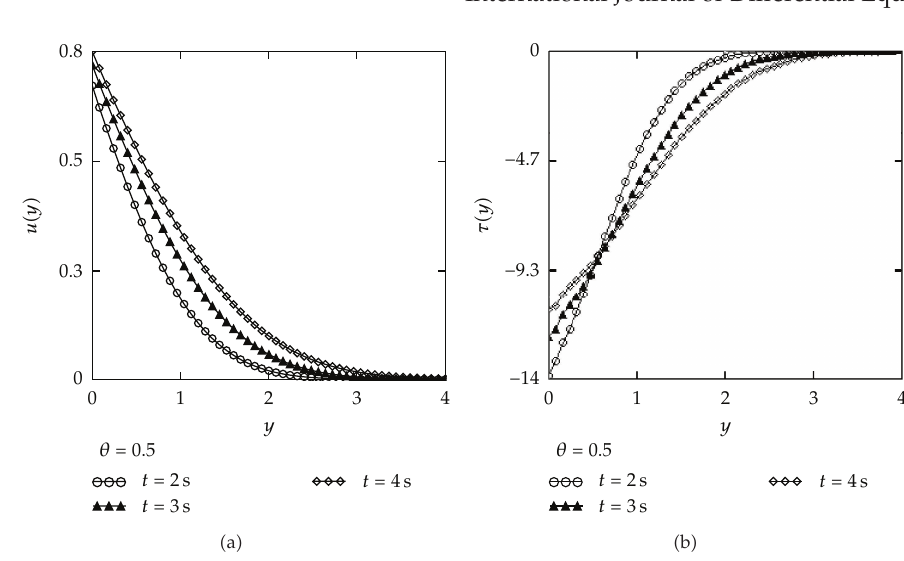
Figure 1: Profiles of the velocity field u (cid:4) y,t (cid:5) and the shear stress τ (cid:4) y,t (cid:5) for fractional Maxwell fluid given by (cid:4) 4.7 (cid:5) and (cid:4) 4.15 (cid:5) , for U (cid:9) 1, y (cid:9) 1, ν (cid:9) 0 . 379, μ (cid:9) 33, λ (cid:9) 1 . 5, α (cid:9) 0 . 2, θ (cid:9) 0 . 5, and di ff erent values of t